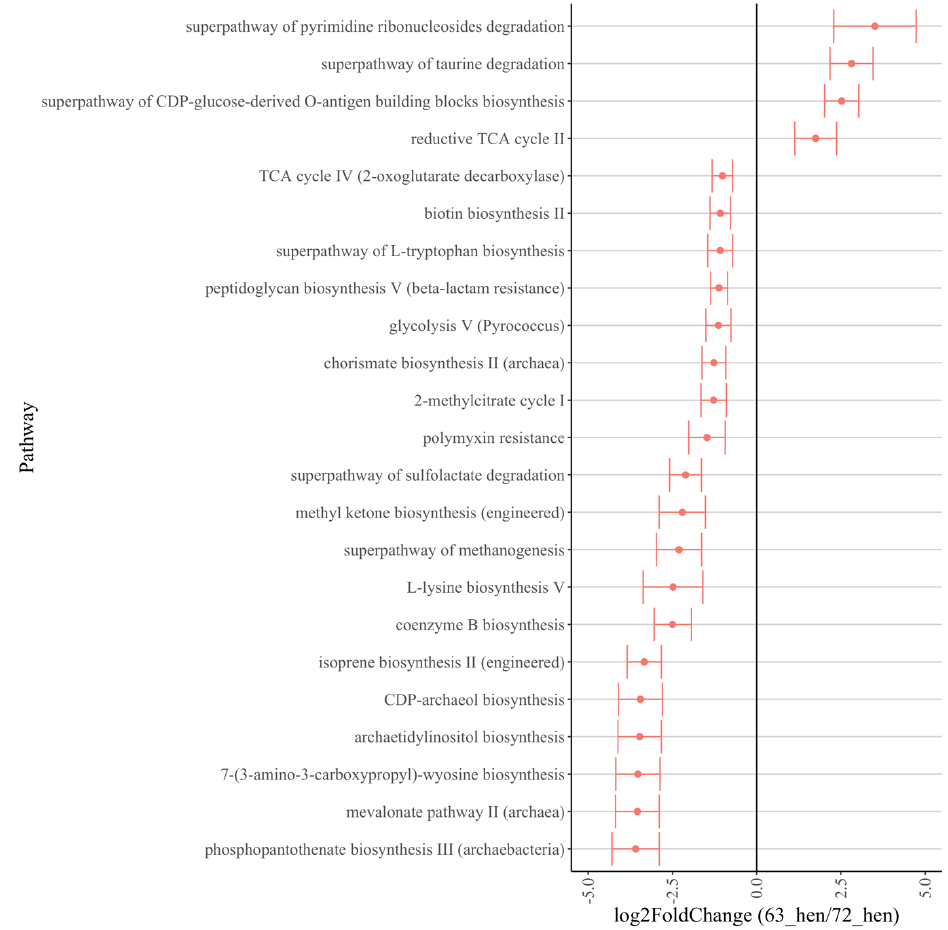
Figure 6. MetaCyc pathway difference predictions using 16S rRNA data with PICRUSt2 between hens from line 63 and line 72 (>1 log2 fold change). Positive “log2 fold change” values (x-axis) indicate higher expression of certain pathways in 63-hens, and negative values indicate higher expression in